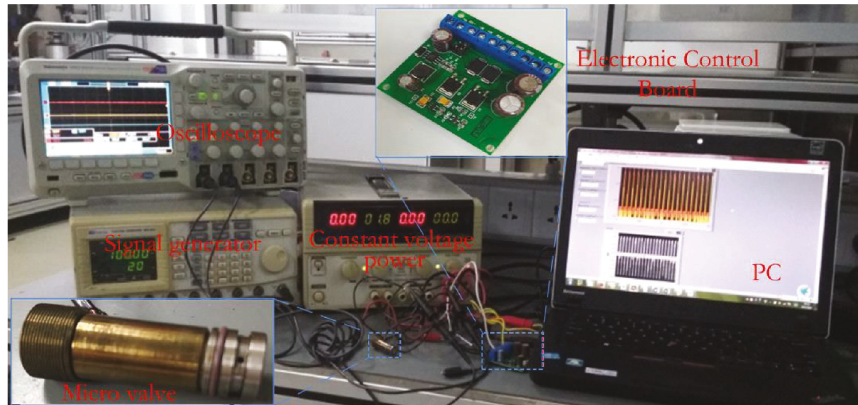
Figure 14: Electronic control board test bench.